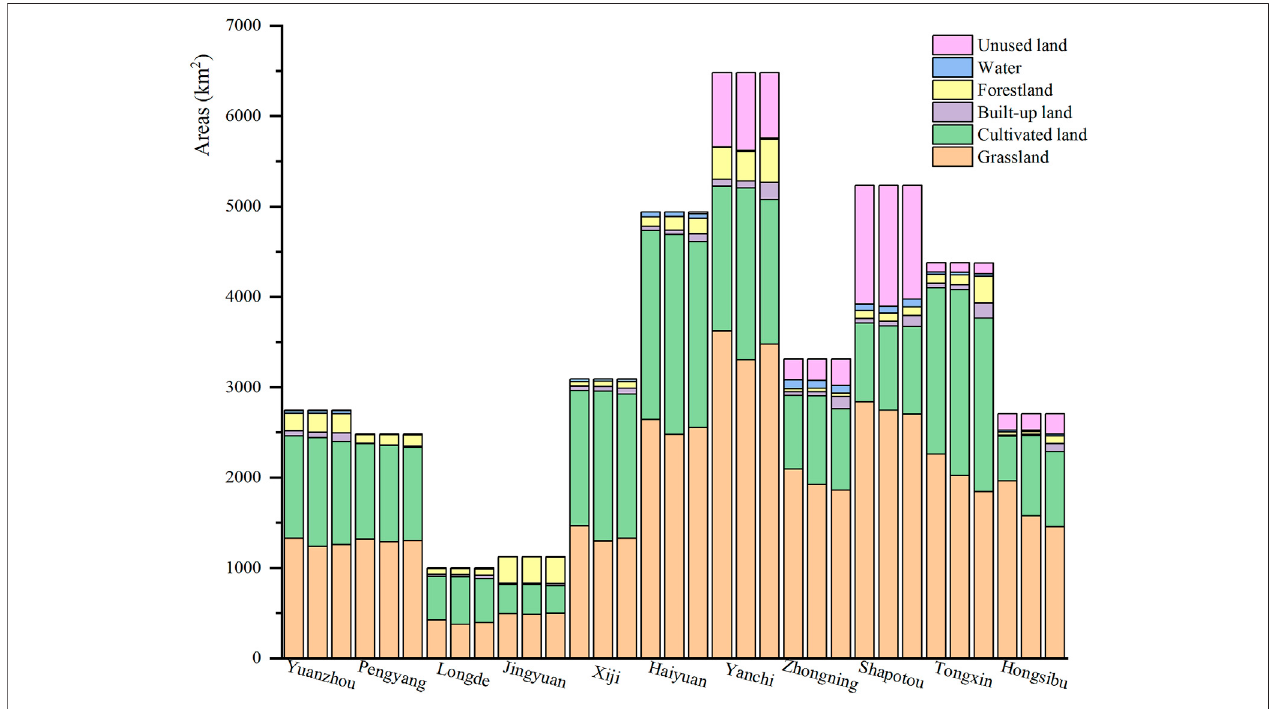
FIGURE 4 | Stacked column chart showing the area of land-use types in 1990, 2000, and 2008 from left to right.